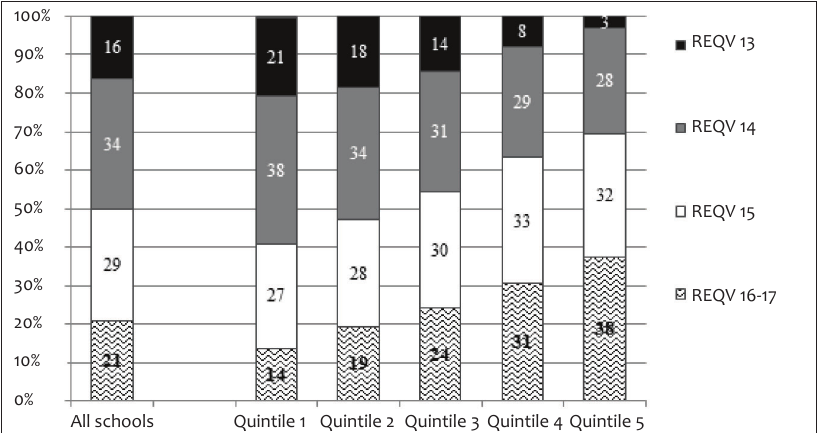
Figure 3: Principal qualifications (REQV), 2012 Source: Persal-EMIS matched dataset, own calculations. Notes: Not shown in the figure are almost negligible percentages of principals in each quintile that have a REQV level less than thirteen (i.e. under-qualified). Specifically 0.24% (18) of principals in Quintile 1 schools, 0.09% (5) of principals in Quintile 2 and 0.04% (2) of principals in Quintile 3 schools have a REQV level less than thirteen (i.e. under-qualified). Percentages add up to 100 % in each